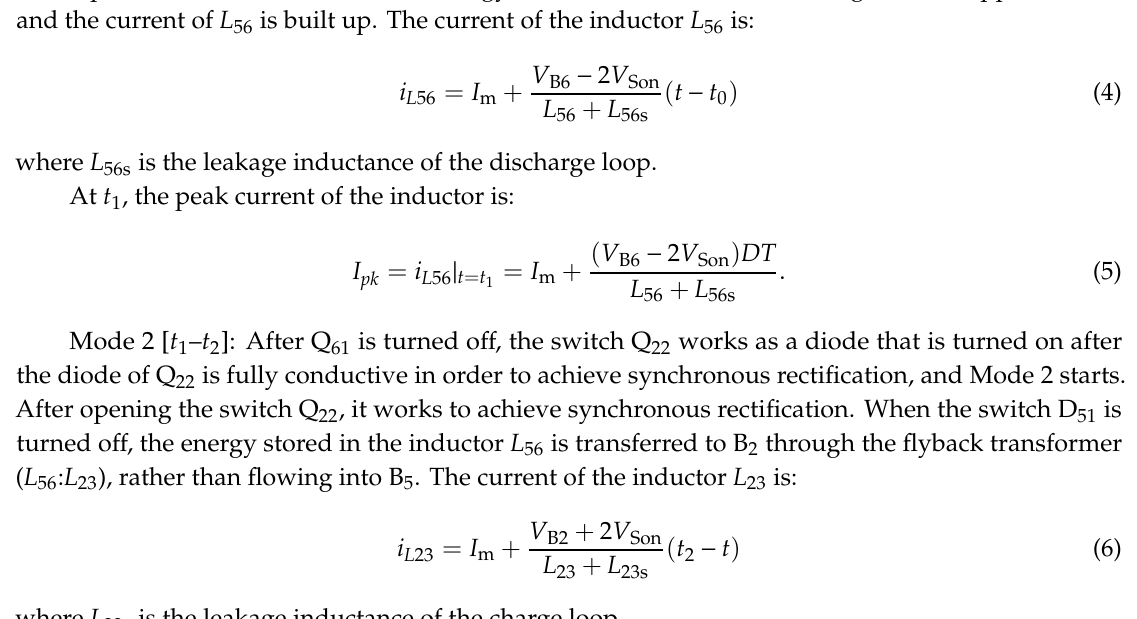
Figure 10. Simplified circuit model with equivalent leakage inductance. The peak current of i 1 is: